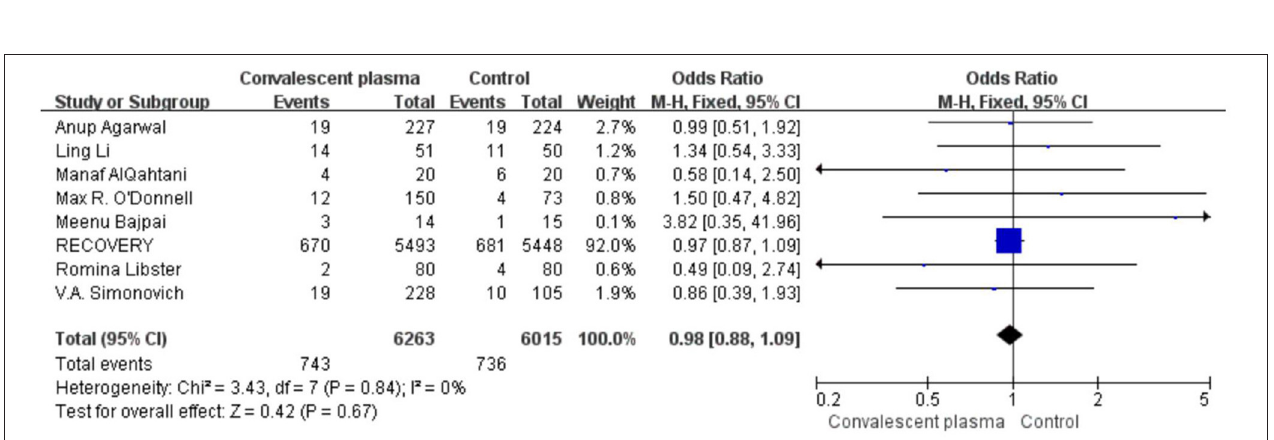
Frontiers in Medicine |